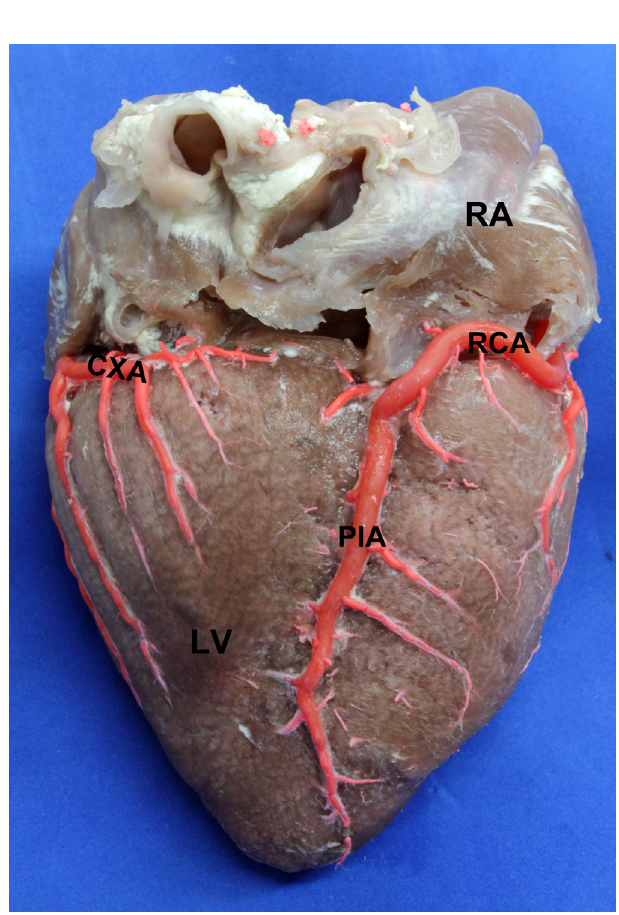
Fig. 4 - Posterior view of the heart. LV: Left Ventricle. RA: Right Atrium. RCA: Right Coronary Artery. PIA: Posterior Interventricular Artery. CXA: Circumflex Artery, ending near the crux cordis